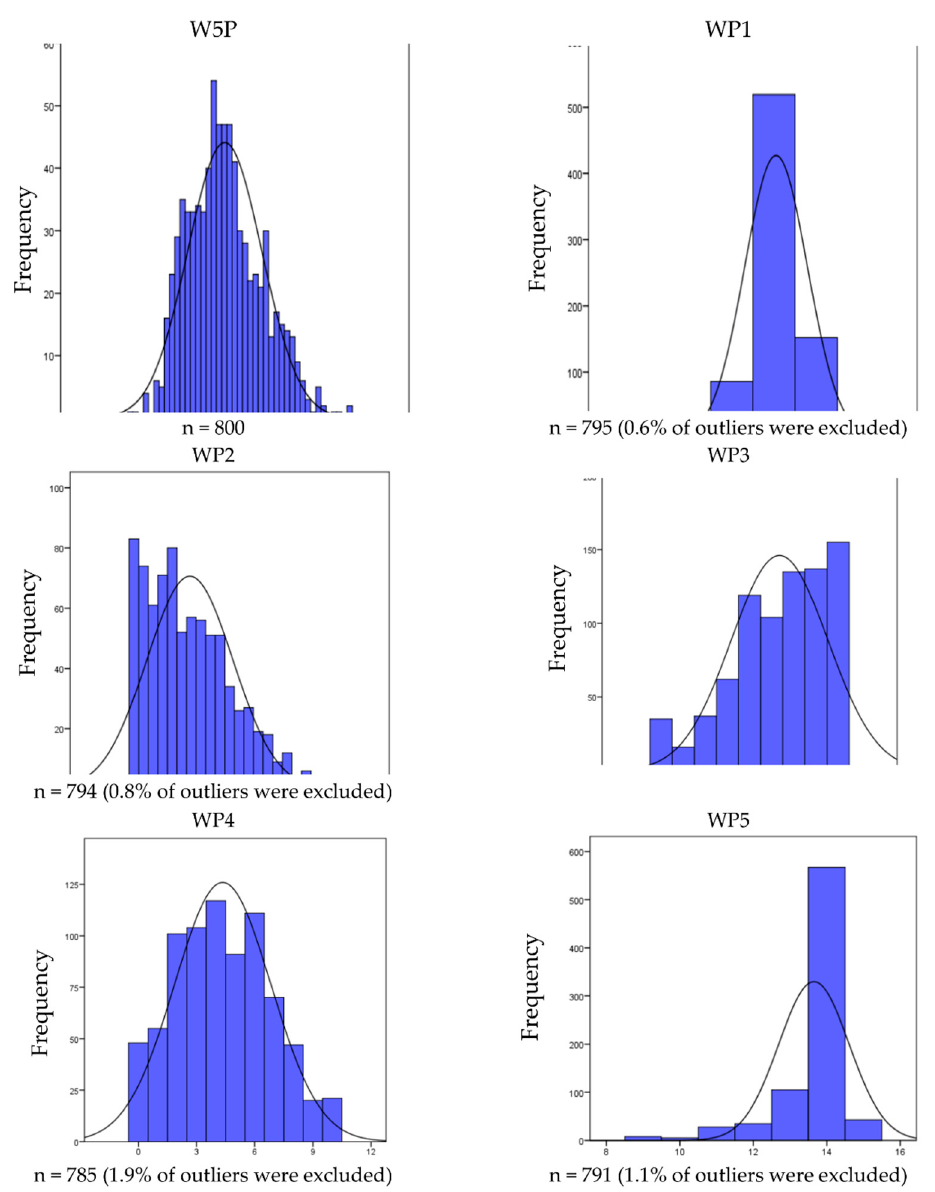
Figure 1. Distribution of 5P architecture indicators in medium and large companies in Poland. Source: research source.